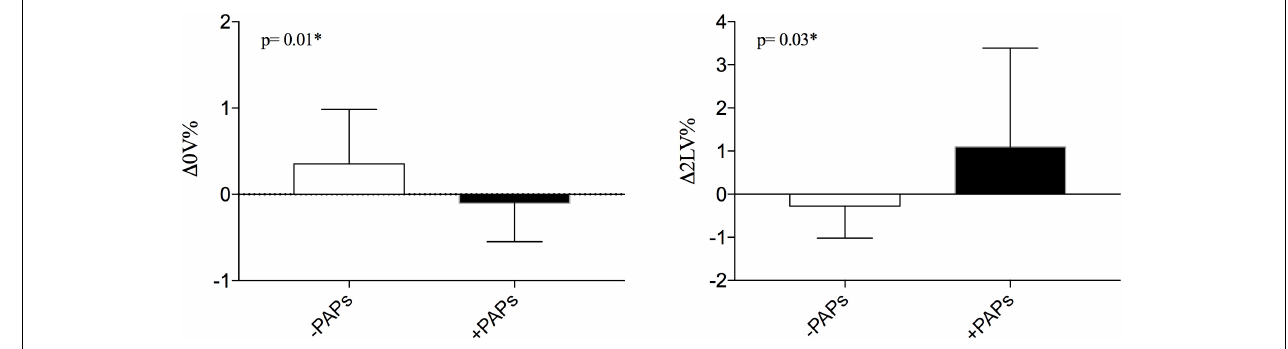
FIGURE 2 | Comparisons of dynamic cardiac response to active standing test between –PAPs and +PAPs groups between. PAPs, mean pulmonary artery pressure; PAPs-, PAPs group of PAPs < median; PAPs+, group of PAPs ≥ median; (cid:49) 0V%, [(0V% in supine position-0V% in orthostatic position)/0V% in supine position]. 0V% and 2LV% are non-linear heart rate variability markers of sympathetic and vagal modulation. ∗ p < 0.05 from Mann–Whitney U